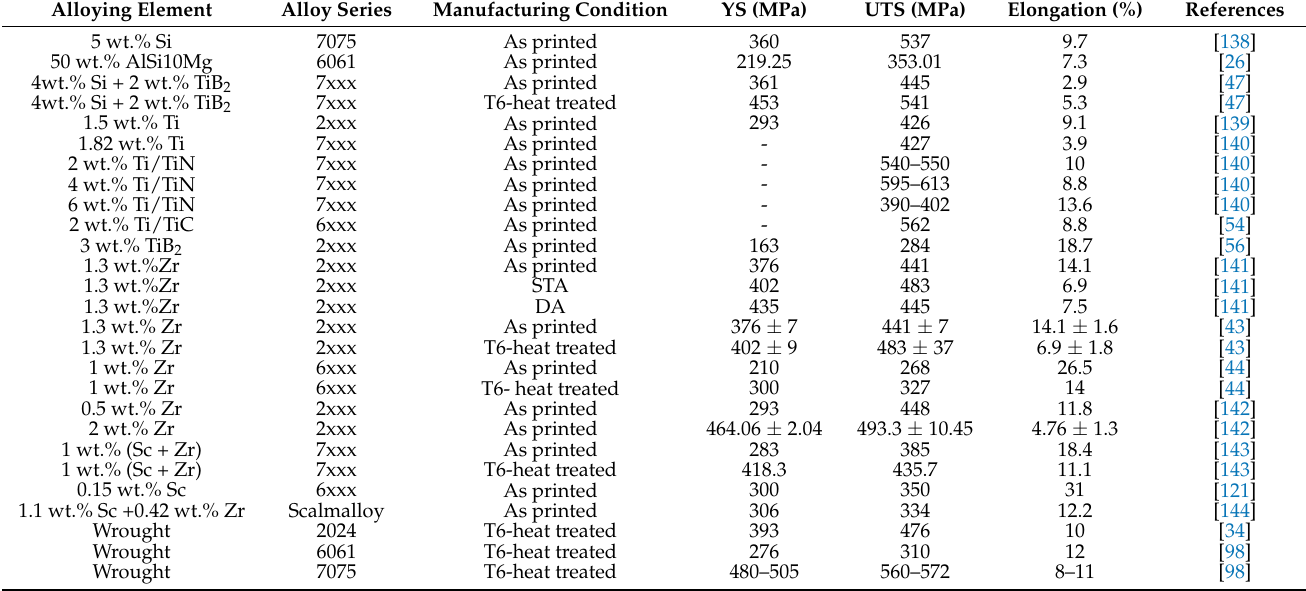
Table 6. Mechanical properties of compositionally modified HS-Al alloys using different alloying additions such as Si, Zr, Ti, Sc, and Ti-based ceramic particles. UTS, YS, STA, and DA represent ultimate tensile strength, yield strength, solution treatment aging, and direct aging,